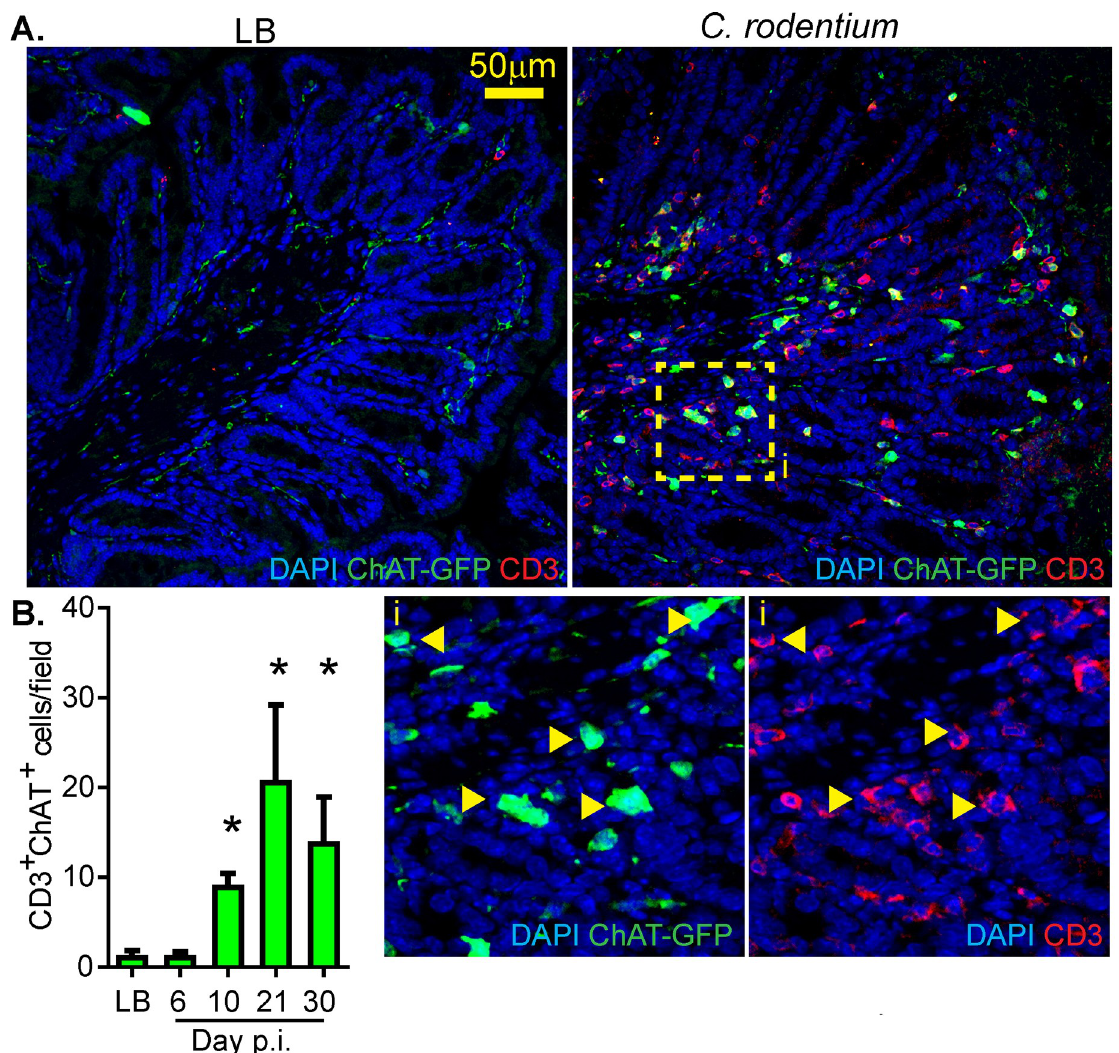
Fig 1. Infection with C. rodentium recruits ChAT+ T-cells to the colon. (A) Confocal microscopy was conducted on colonic tissues from LB or C. rodentium infected ChAT-GFP reporter mice using DAPI, anti-CD3, and anti-GFP. (B) These CD3+ ChAT-GFP+ cells (inset “I”) where then quantified in 5 random fields from LB control, or 6, 10, 21, or 30 days post-infection with C. rodentium. � P < 0.05 ANOVA, with n = 5–6 mice per